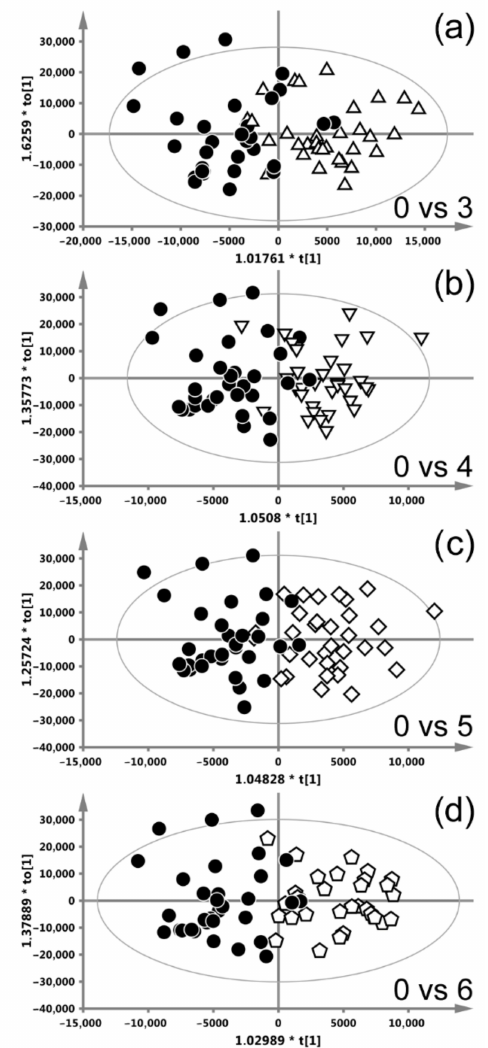
Figure 3. OPLS-DA score plots differentiating week-0 from the consecutive weeks of radiotherapy (RT) with CAIR/CONV/SIB fractionation. Week-0 vs. week-3 ( a ), week-4 ( b ), week-5 ( c ) and week-6 ( d ). The models differentiating the remaining weeks from week 0 were not